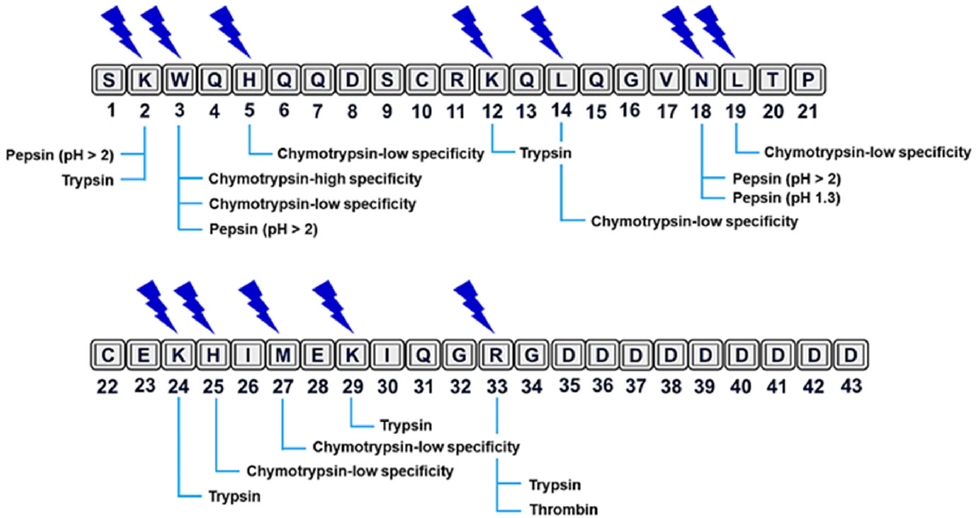
Figure 1. Prediction of cleavage sites for digestive and plasmatic proteases in the lunasin sequence. PeptideCutter (available from: https://web.expasy.org/peptide_cutter/, accessed on 8 June 2021) was utilized for prediction. Predicted cleavage sites are indicated with blue lightning bolts, and putative enzymes for each site are indicated along the bottom of the figure.